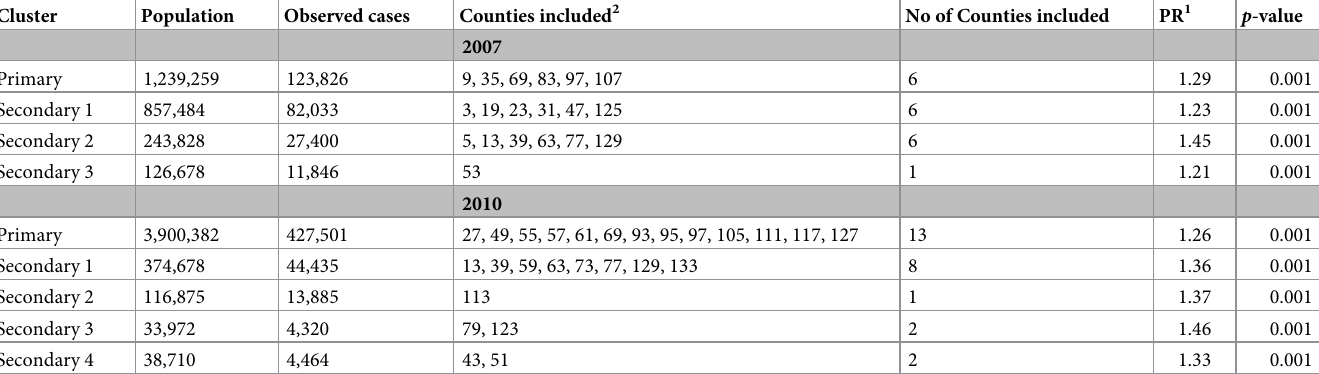
Table 2. Purely spatial unadjusted high-prevalence diabetes clusters in Florida, 2007 and 2010.